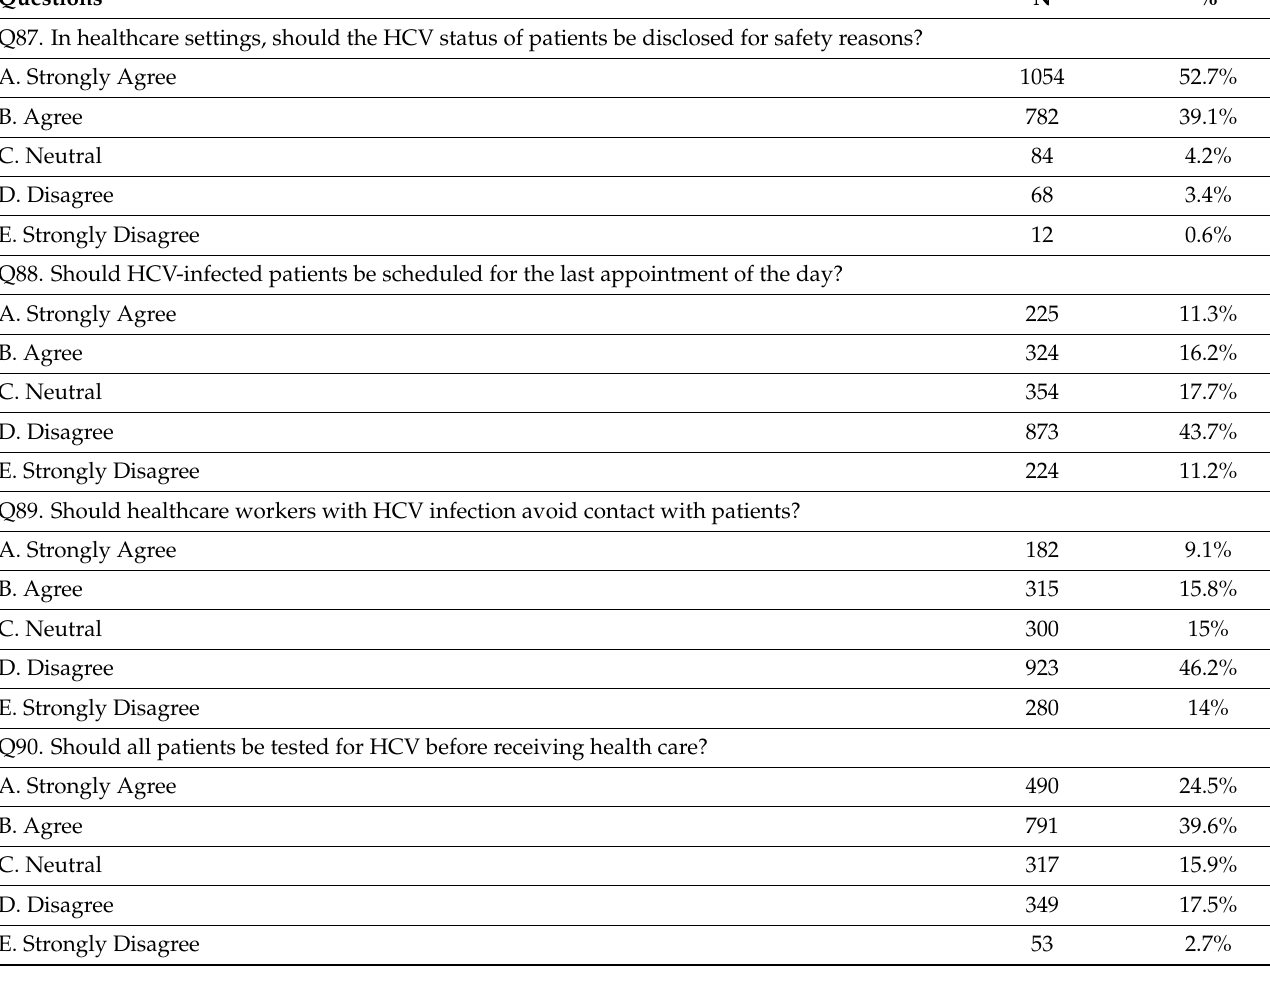
Table 4. Students’ attitudes toward HCV (n = 2000).